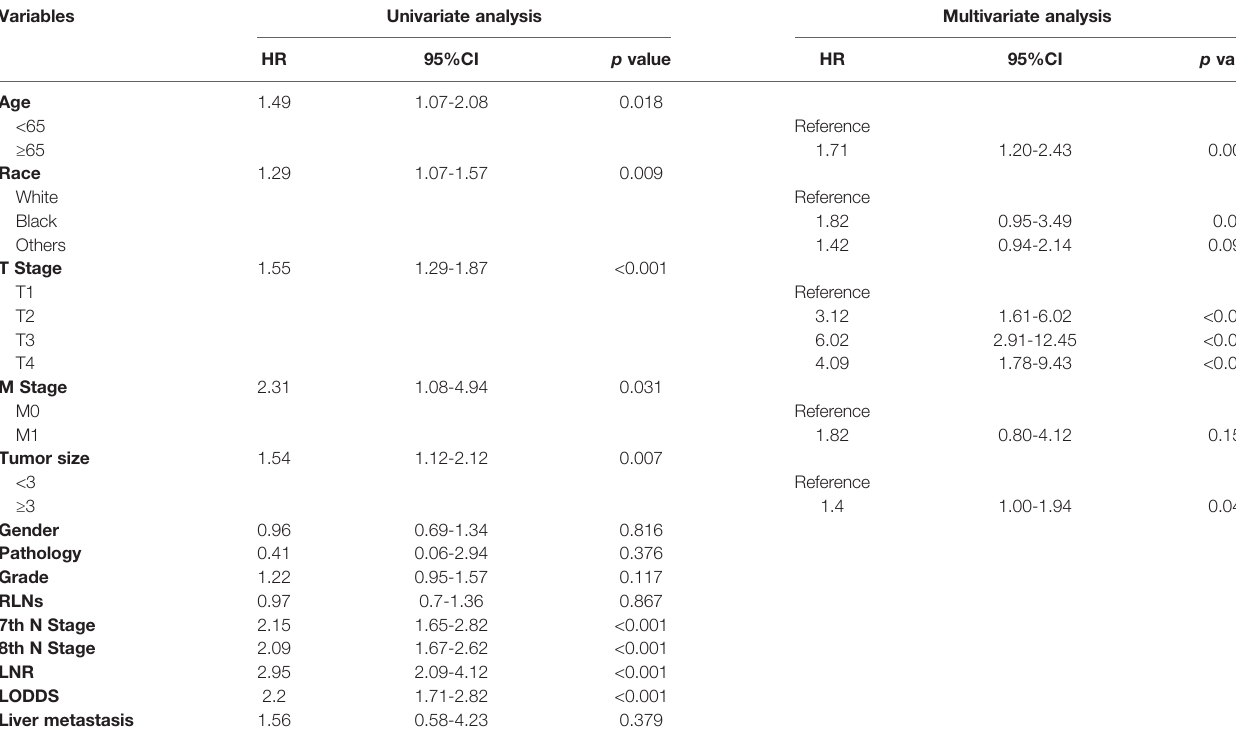
TABLE 3 | Univariate and multivariate Cox analysis of prognostic factors. Variables